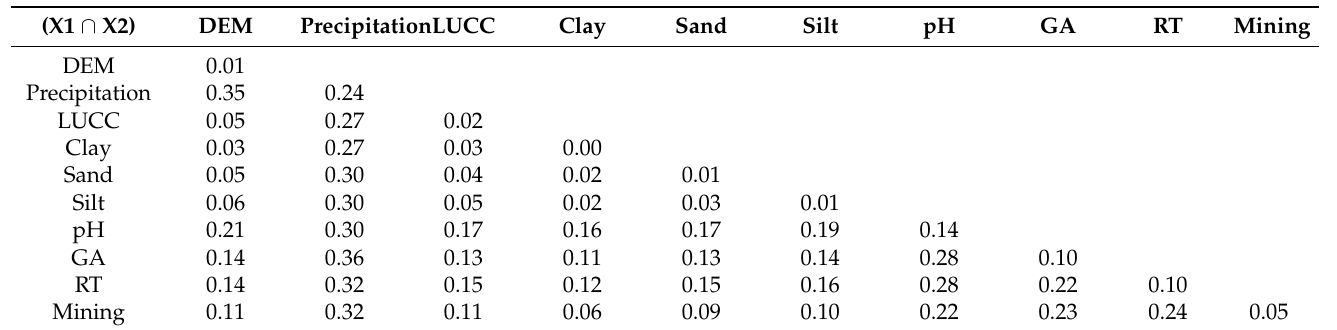
Table 5. Effects of the interaction between each pair of driving factors on the enrichment of the Ni concentration in the YTRB.